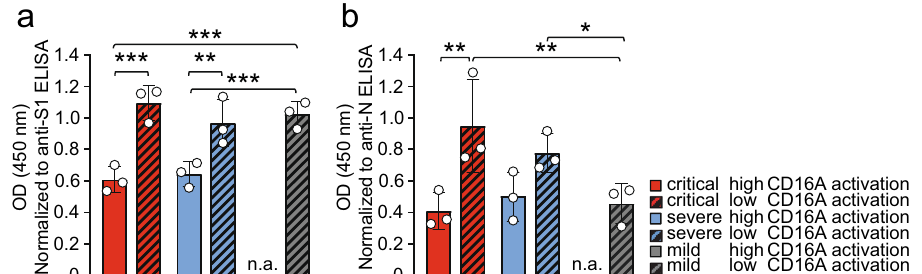
Fig.3|AntiSARS-CoV-2IgGFccorefucosylationincriticalandsevereCOVID-19 cases. IgG-Fc core fucosylation levels of SARS-CoV-2 – speci fi c IgG in critically (red bars), severely (blue bars) and mildly (grey bars) diseased COVID-19 patients. Analysis was carried out on a pool of 5 different sera. Measured OD values (fuco- sylation) of the generated eluates were normalized to their respective IgG con- centrations determinedby antigen-speci fi c S1and N ELISA. a S-IgG-Fc-fucosylation and b N-IgG-Fc-fucosylation in critically and severely diseased patients character- ized byeitherhigh(red)orlow(patterned)CD16A-activationlevelsintheFc γ RIIIA/